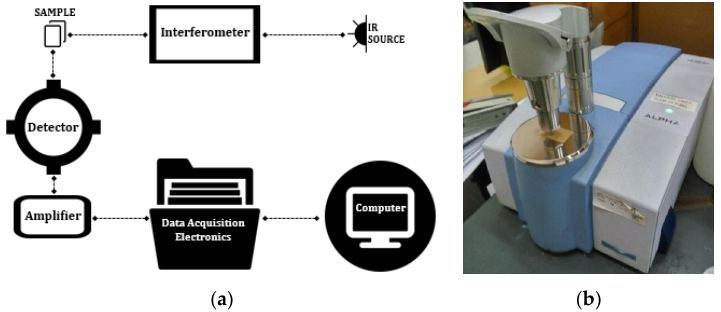
Figure 1. ( a ) Schematic diagram of Fourier transform infrared (FTIR) spectrometer. ( b ) ALPHA FTIR spectrometer.